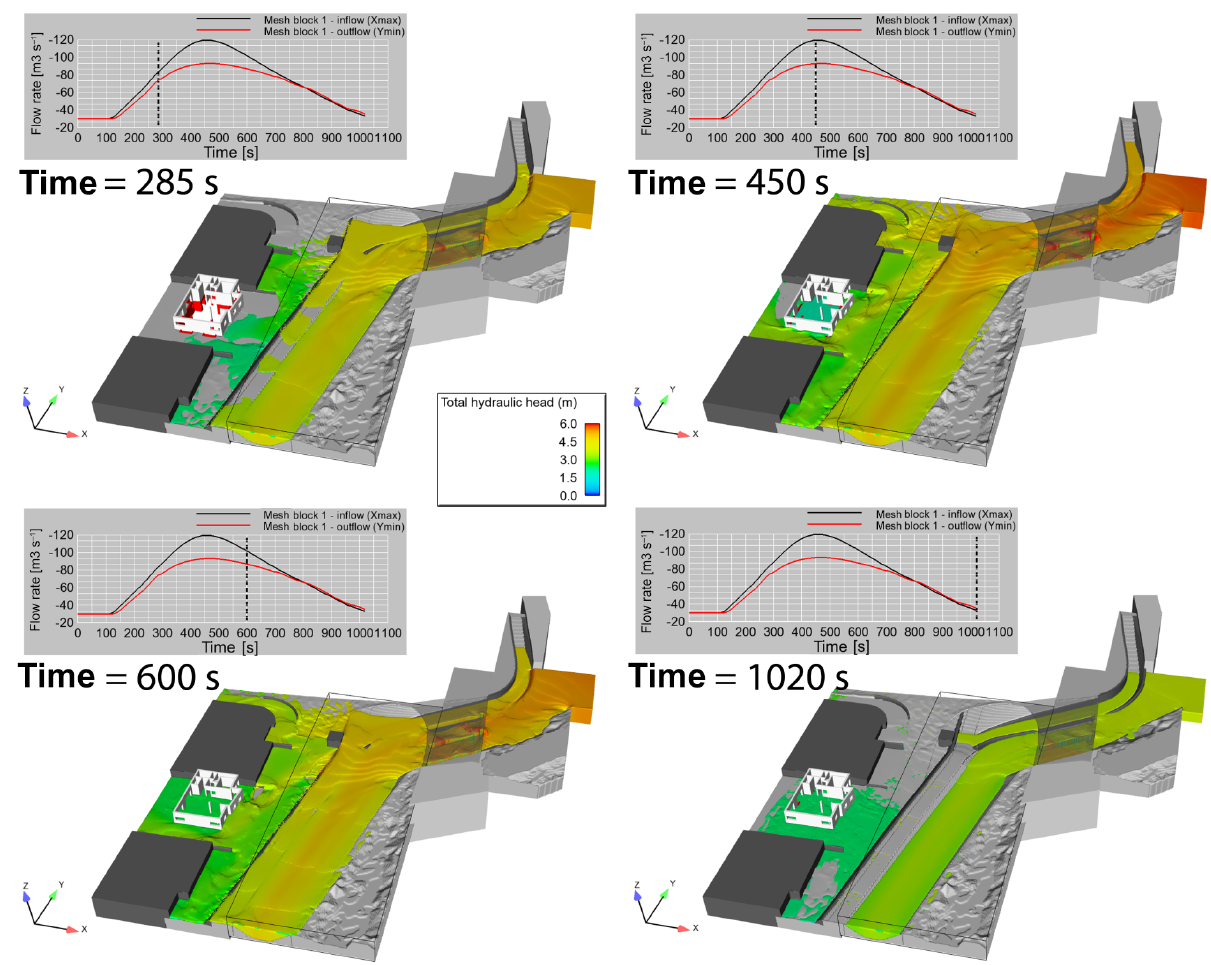
Figure 6. Modelling results for scenario (b) after 285, 450, 600 and 1020s of simulation – perspective view of the stl-geometries and the fluid isosurface representing the total hydraulic head (m), boundary flow rates (Xmax, Ymin) for mesh block mb1.